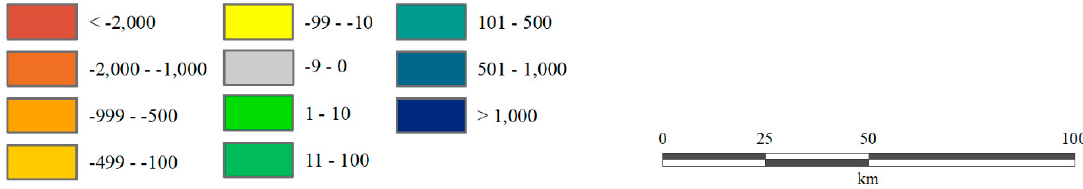
Figure 10. Urban population change in Riyadh province during 2004 and 2010.